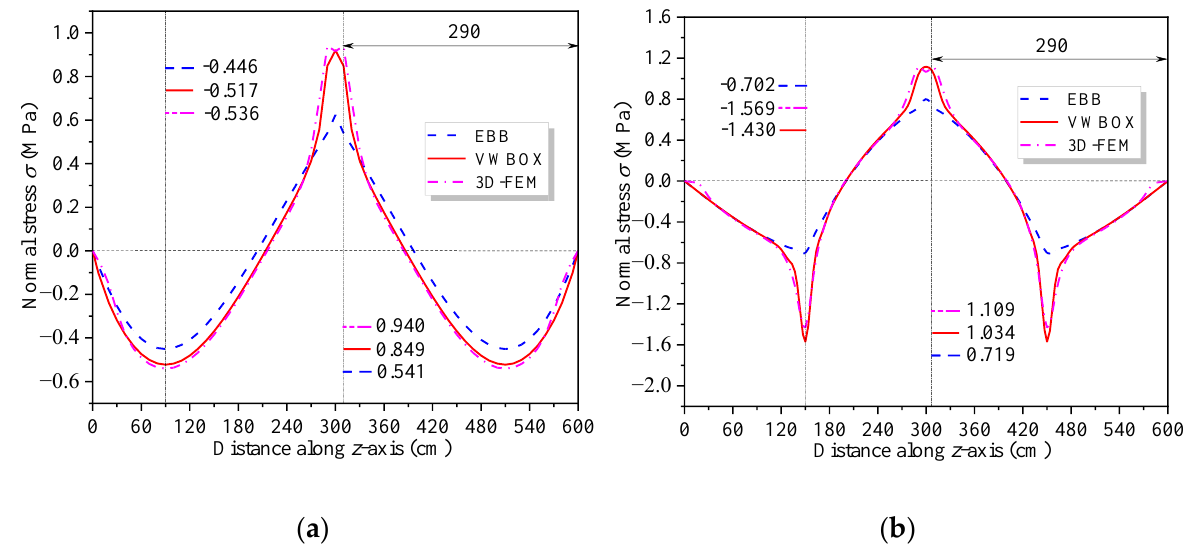
Figure 17. Normal stress distribution along the beam axis at the top of the upper flange under different load cases: ( a ) Case 1; ( b ) Case 2.